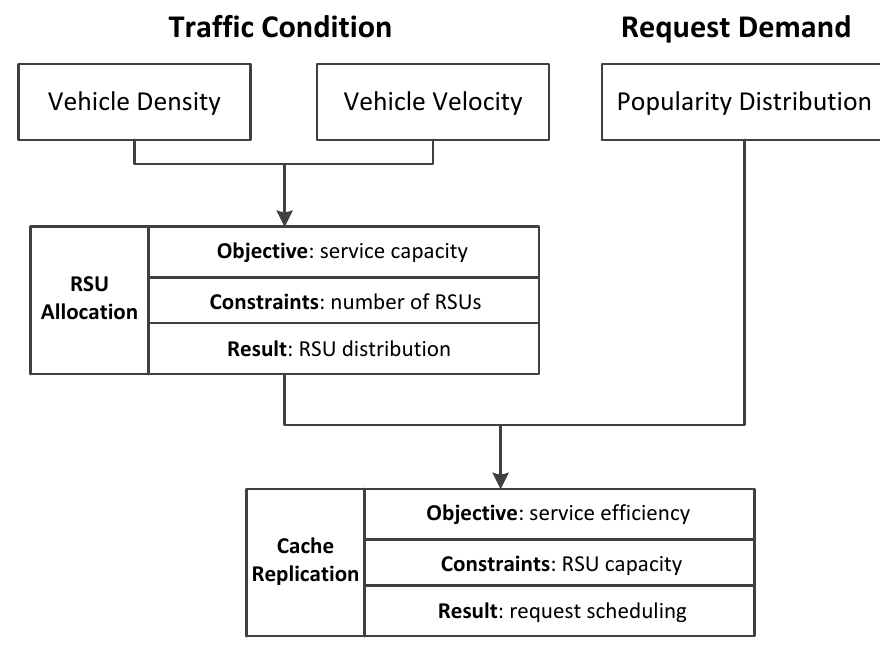
Figure 2. RSU scheduling strategy